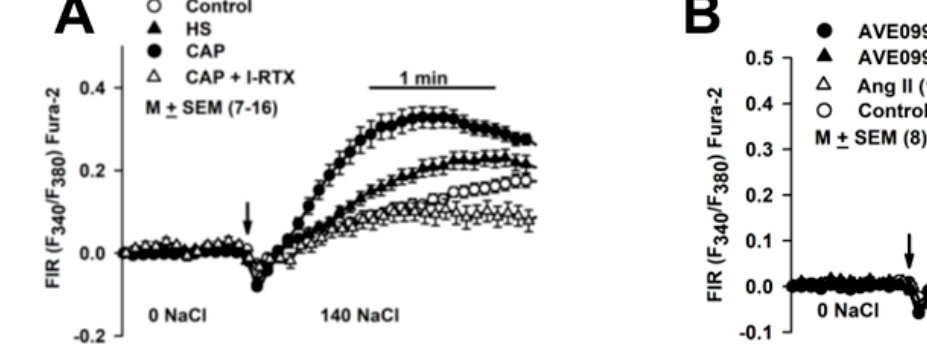
Figure 10. Regulation of Na + influx by HS, CAP, AVE0991, and Ang II. ( A ) Effect of culturing HBO cells in media containing HS and CAP on Na + influx. Na + flux-induced secondary changes in [Ca 2+ ] i were monitored in HBO cells in response to an increase in bath Na + from 0 to 140 mM. The increase in initial slope ( Δ FIR/min) and V max were measured under each experimental condition. Values are mean (M) ± SEM of changes in FIR in 7–16 wells. ( B ) Effect of culturing HBO cells in media containing AVE0991 and Ang II on Na + influx. Values are mean (M) ± SEM of changes in FIR in 8 wells.